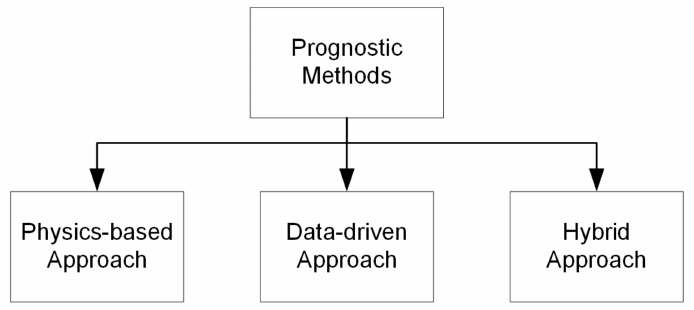
Figure 1. Main Prognostics